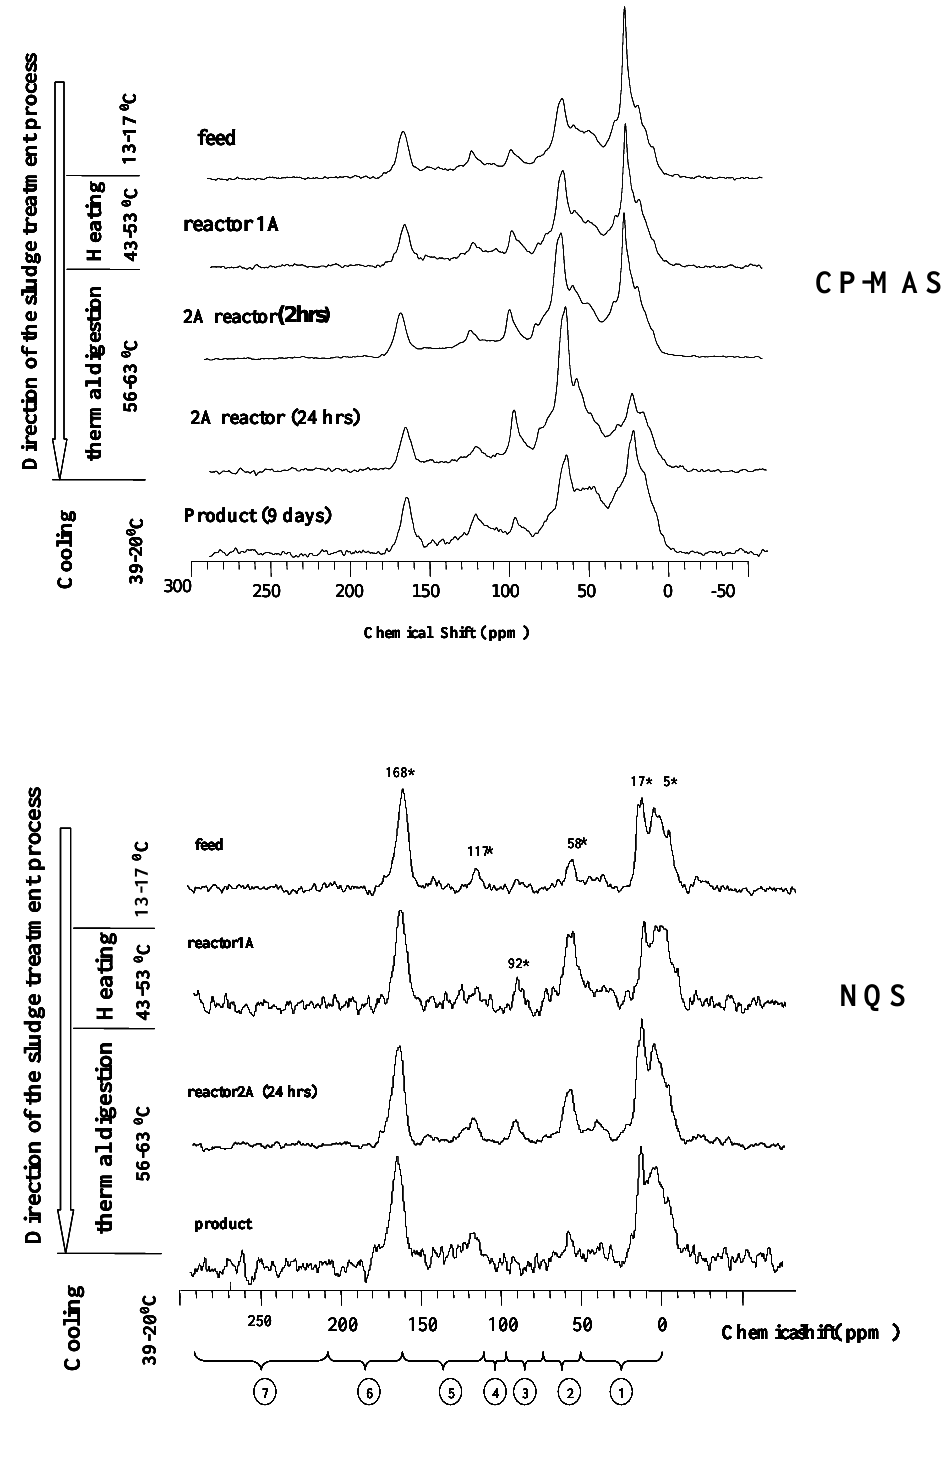
Figure 2. Cross polarization and magic angel spinning (CP-MAS) 13C-NMR and Non- Quaternary suppression spectral editing (NQS) spectra of sludge material at different stages of ATAD processing. Temperature and the process steps are shown as a bar on left side of the chart. Axes representing chemical shift are shown in